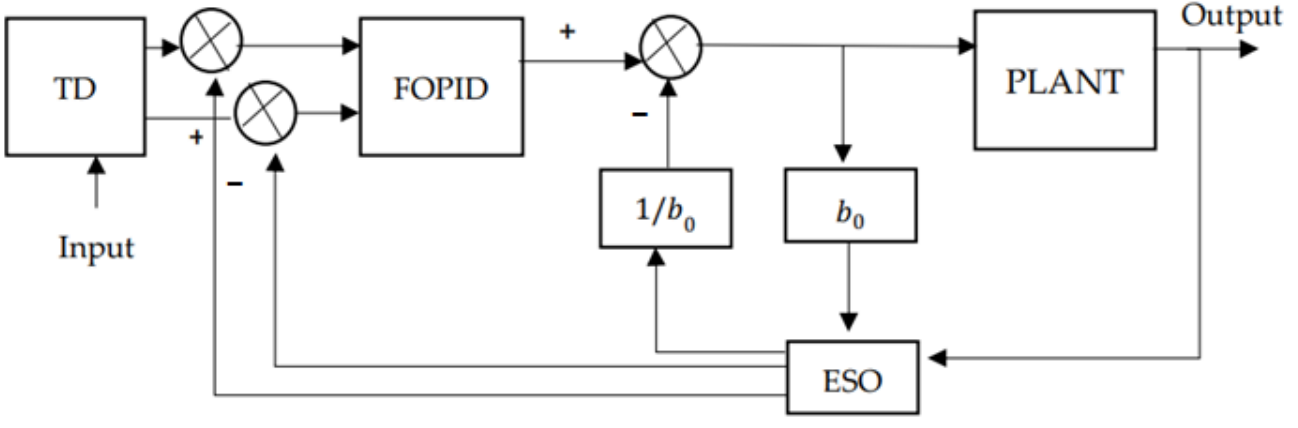
Figure 21. Block diagram of ADRC structural control system [102].